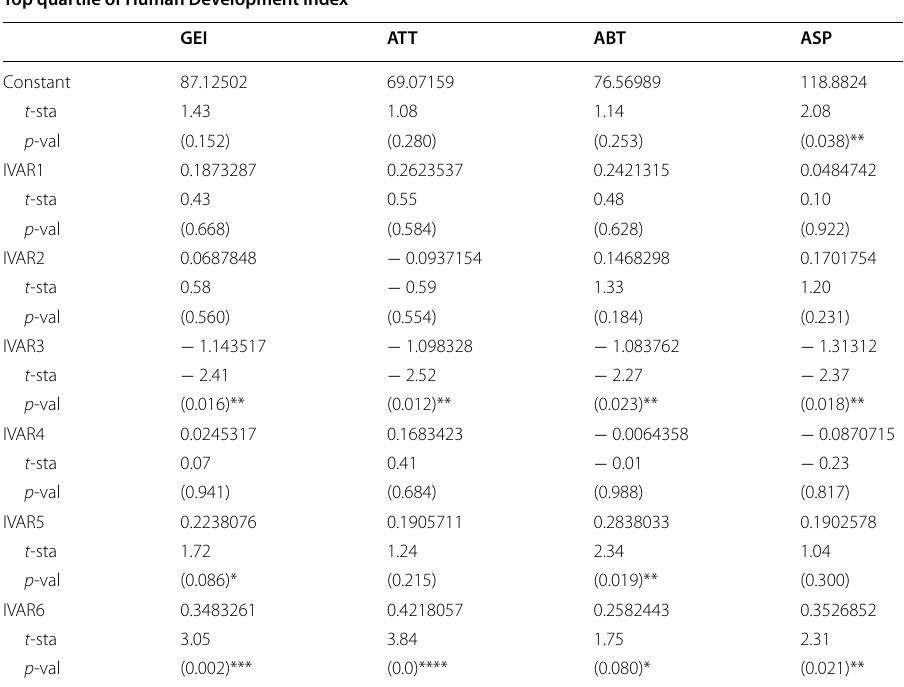
Table 6 Correlated panel corrected standard error regression results Top quartile of Human Development Index